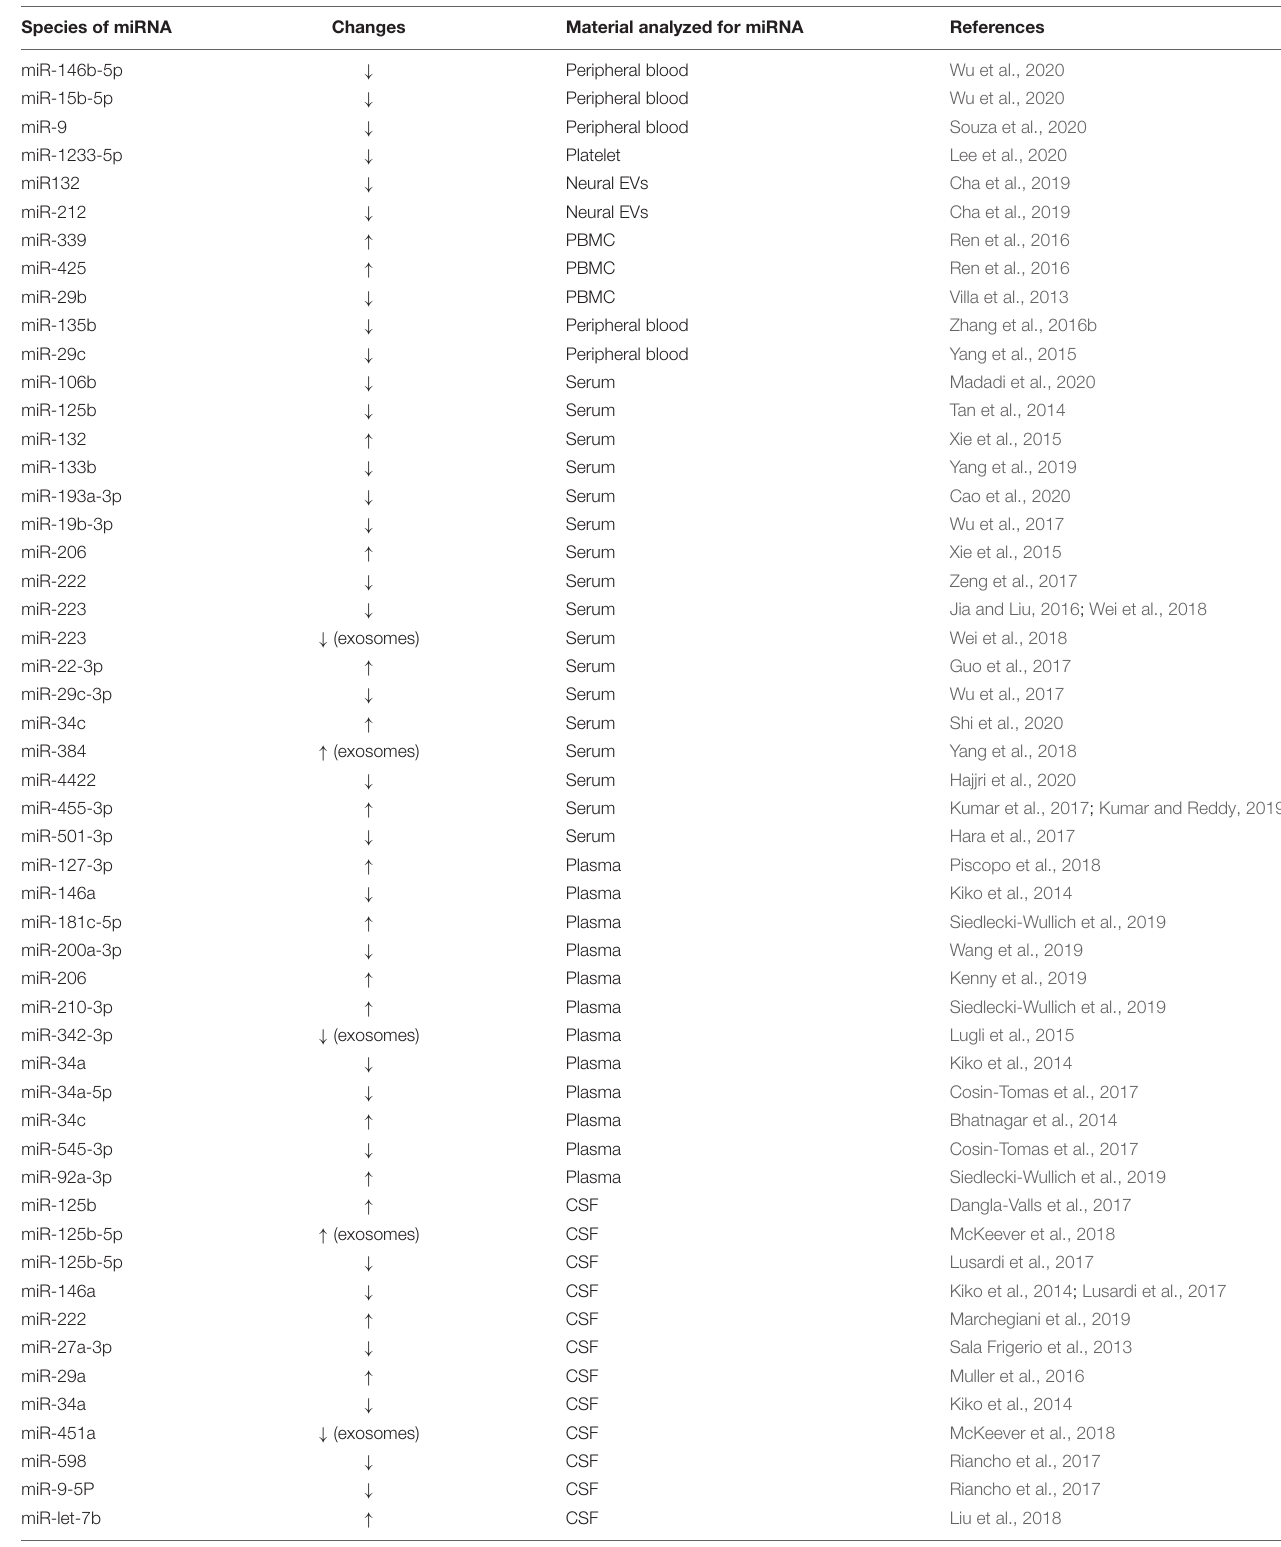
TABLE 2 | MiRNAs in the circulation and cerebral-spinal fluid (CSF) of AD patients. Species of miRNA Changes Material analyzed for